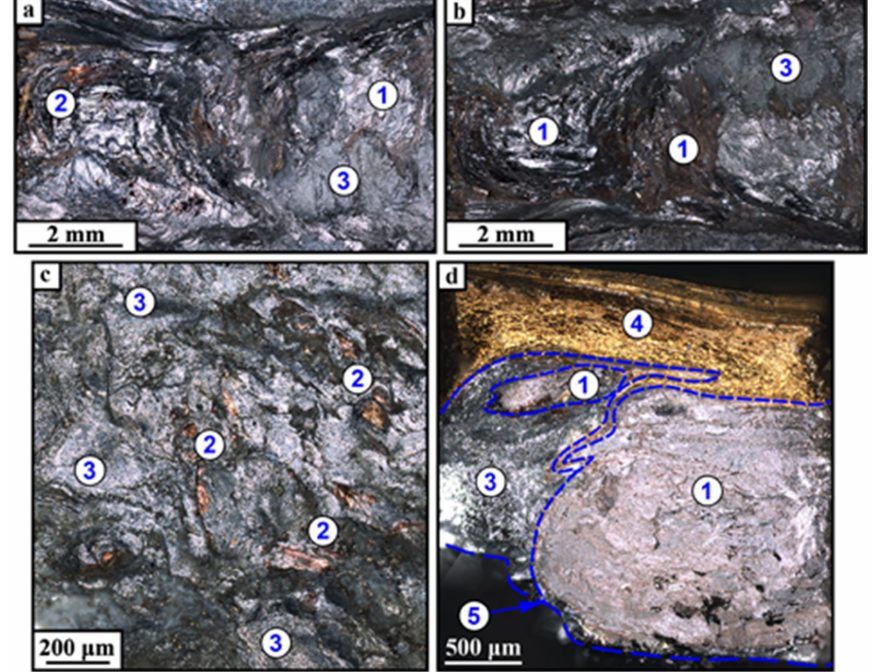
Figure 13. Optical images of normal ( a – c ) and tensile ( d ) fracture surfaces. a —as seen from the bottom upwards; b —as seen from the top downwards; c —enlarged fragment of the normal fracture